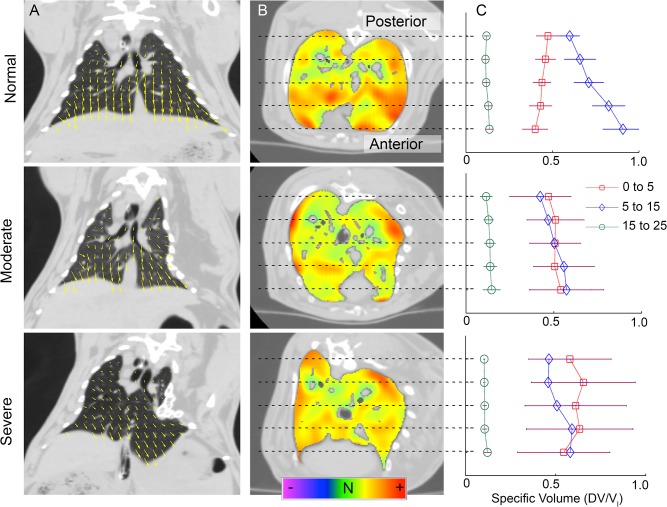
Local specific volume.Comparison of image registration results between Normal (top row), Moderate (center) and Severe (bottom) rabbits. Column (A): coronal slice with the registration displacement map, magnitude and direction of displacements are indicated by yellow vectors. Column (B): axial slice with derived sVol map, hot colors indicate greater expansion and green neutral. Column (C): Comparison of regional sVol, posterior to anterior, between Normal, Severe, and Moderate rabbits at each phase of inspiration. Error bars show SD.